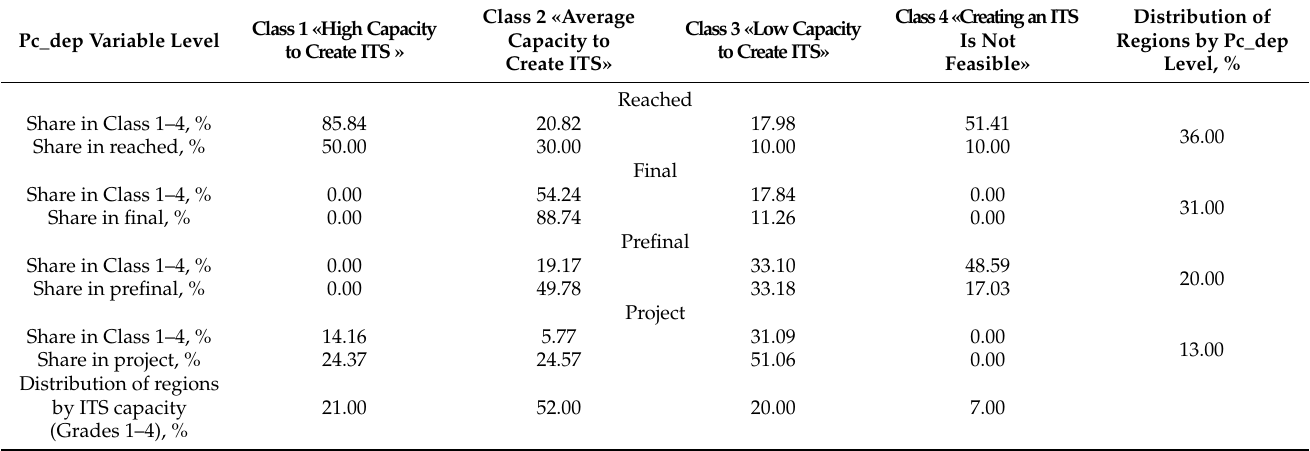
Table 4. «Random forest» distribution matrix for the number of decision trees t =